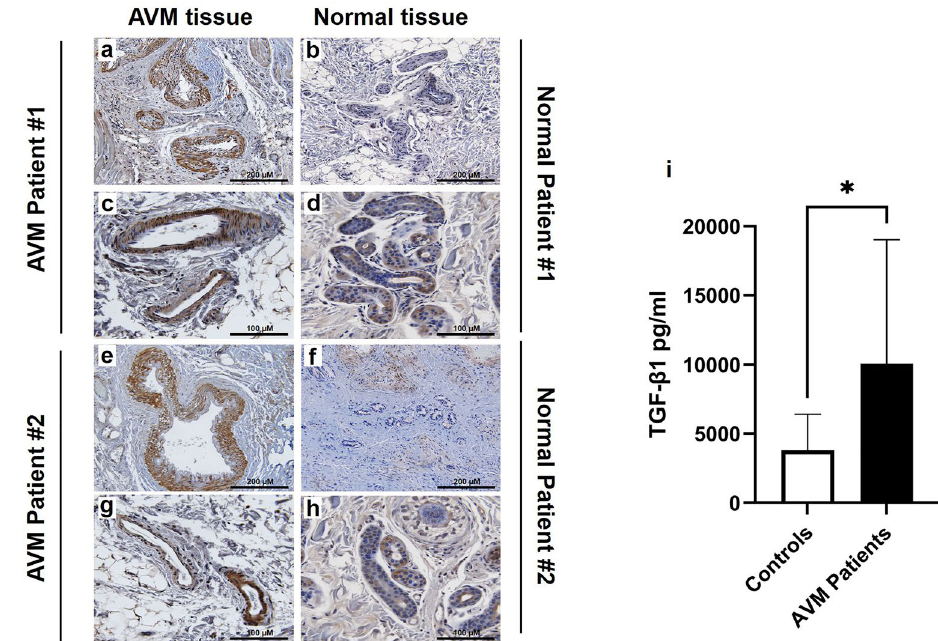
Figure 3. TGF-β1 protein is elevated in AVM perivascular smooth muscle cells and in the circulation of AVM patients. Paraffin-embedded slides prepared from tissue from 2 AVM patients ( a , c , e , g ) and 2 non-AVM patients ( b , d , f , h ) were stained for TGF-β1 protein and photographed under low- and high-power magnification. ( i ) Serum was isolated from blood samples collected from 14 AVM patients and 8 patients without AVMs, and ELISA was performed to determine the total levels of circulating TGF-β1. Error bars represent standard deviation. Paired t tests were performed to determine statistical significance (asterisks: *P < 0.05, **P < 0.01, ***P <